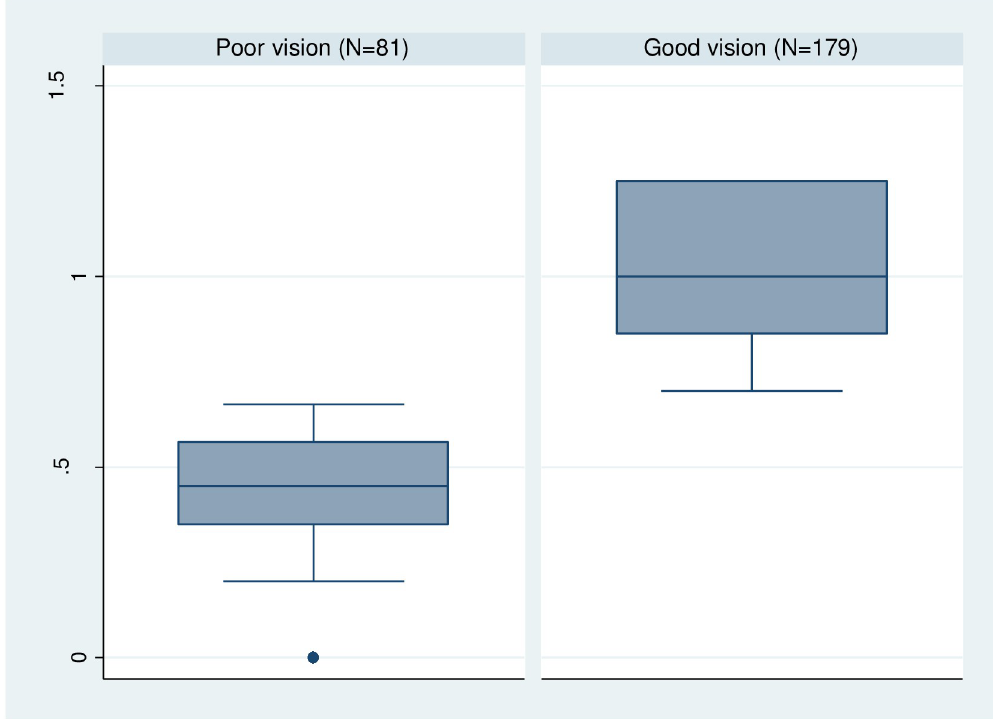
Fig 3. Results from the standardized vision test by visual acuity group. Number of observations = 260. Source: Own depiction.